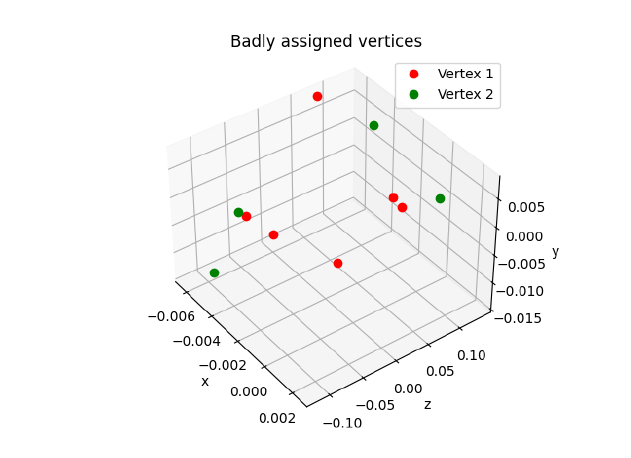
Figure 4: This is an example of a badly assigned set of vertices with z = − 0 . 1cm and z = 0 . 1cm, having ε = 60%, and being quite clear that the assignation is not the correct